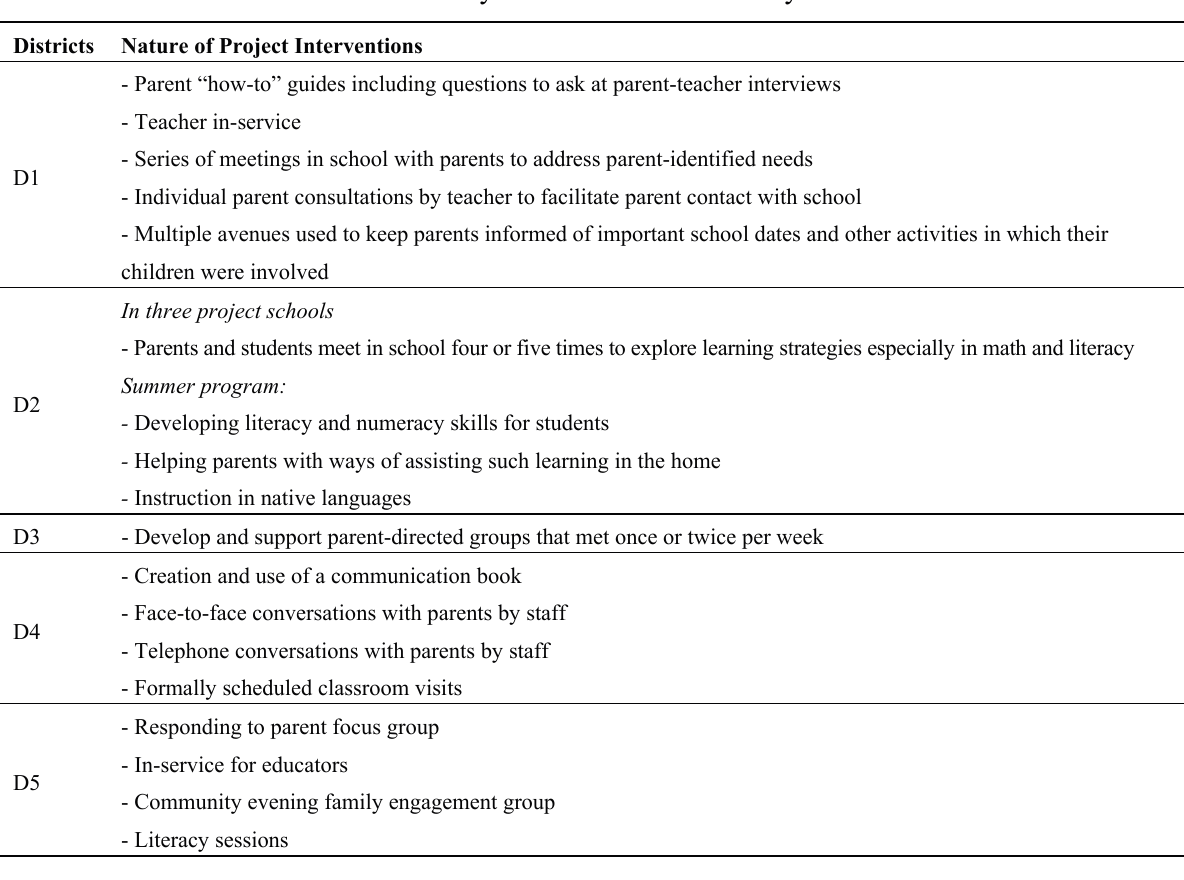
Table 2. Summary of Interventions Used by